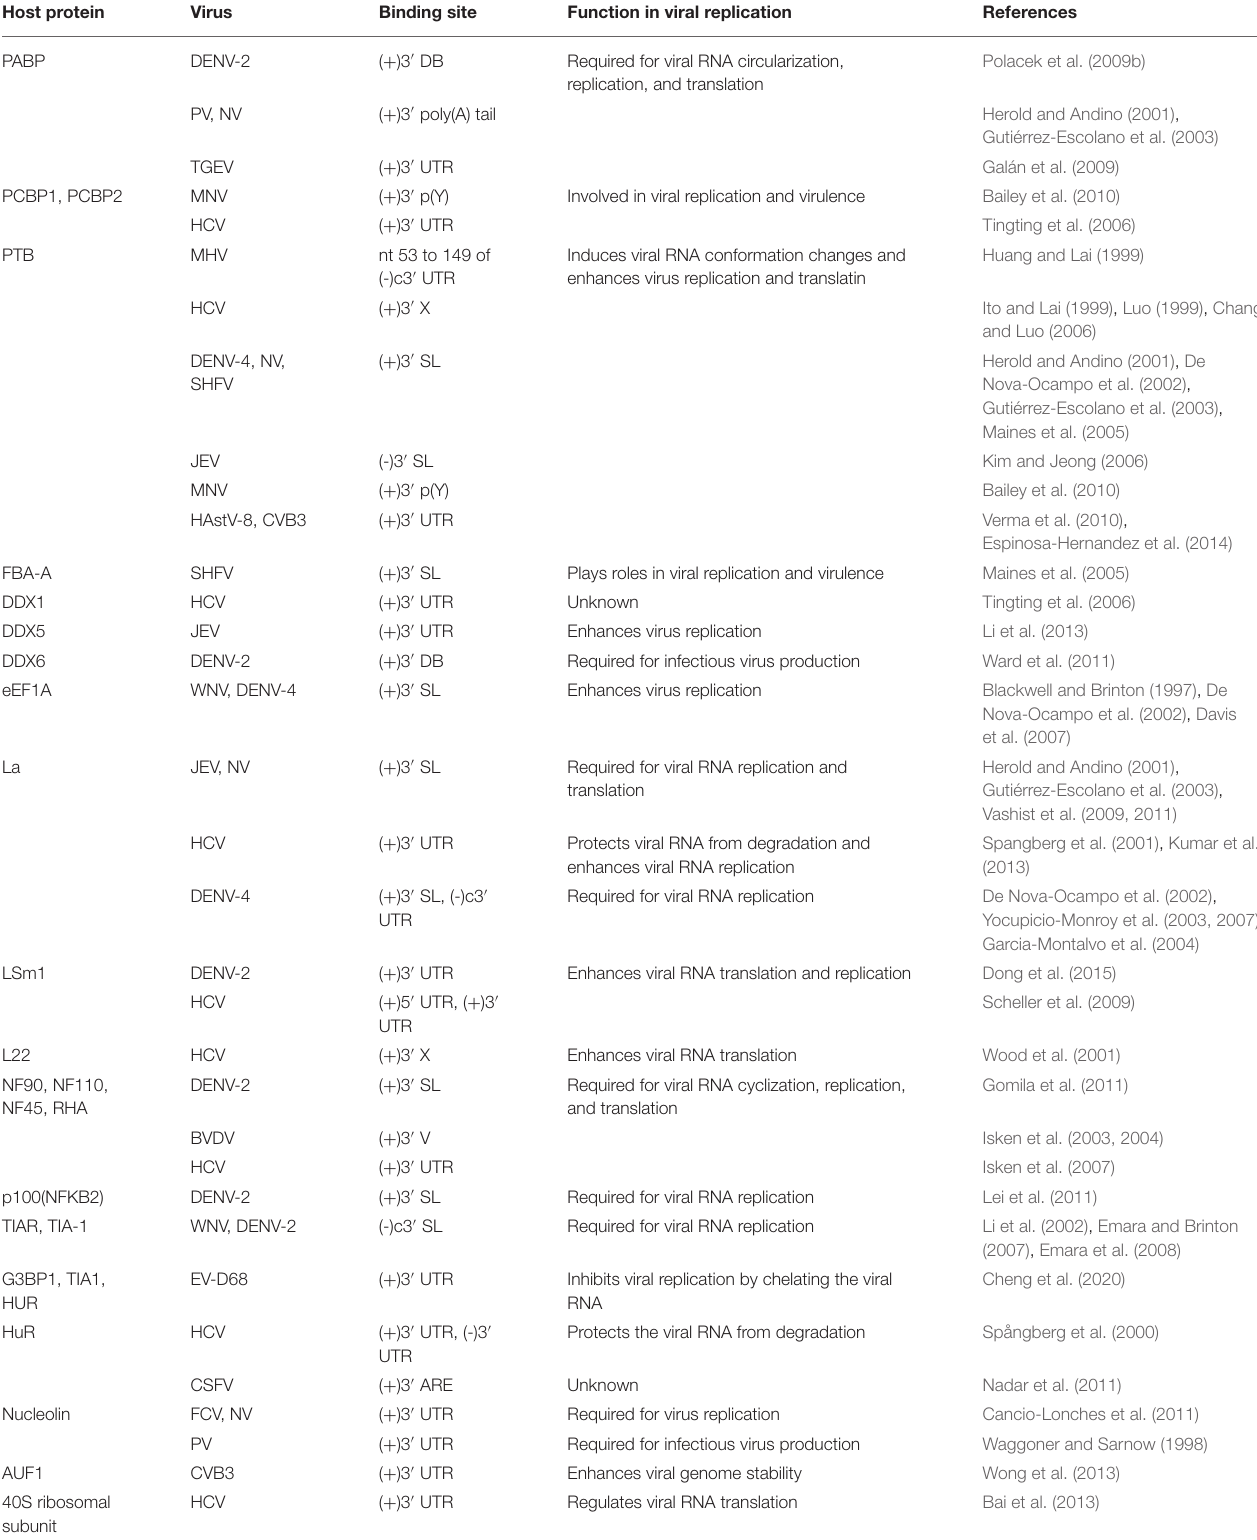
TABLE 1 | Cellular proteins that interact with the 3 ′ UTRs of ssRNA( + ) viruses. Host